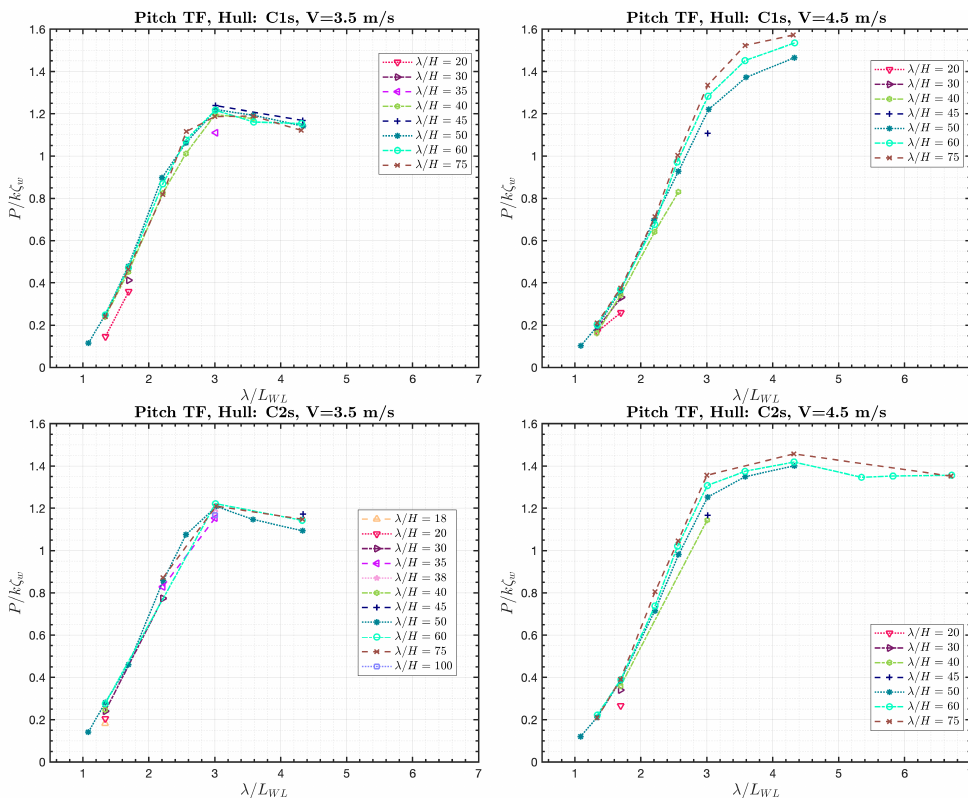
Figure 13. Pitch response vs. λ / L WL